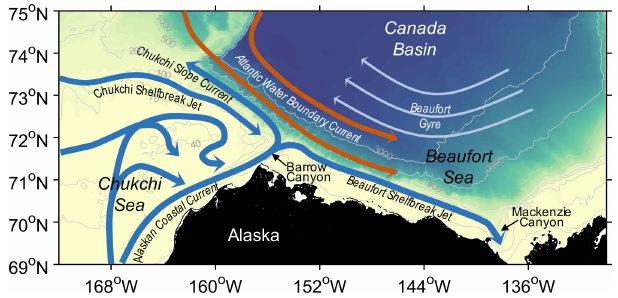
Figure 1. Schematic circulation in the Chukchi and Beaufort Seas; from Leng et al. (2022).